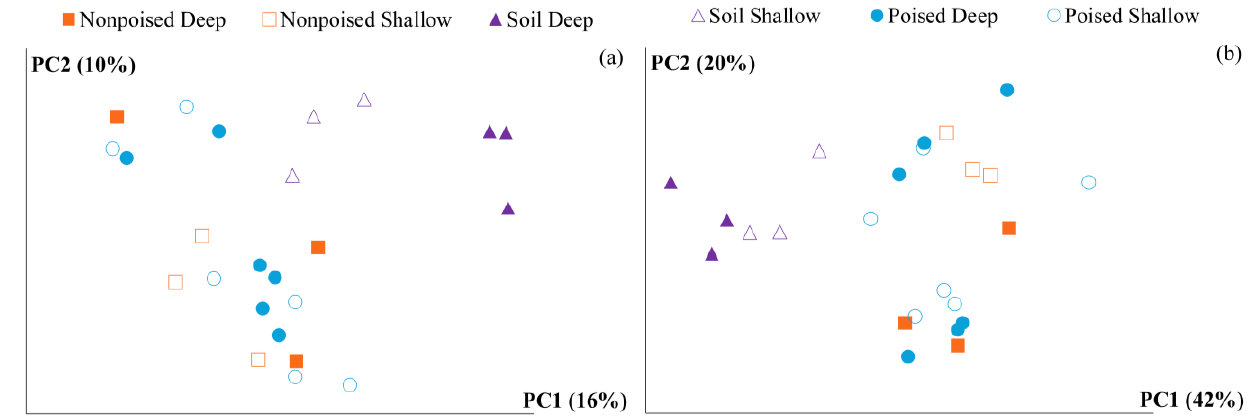
Figure 4. Beta diversity analysis of microbial communities showed using both ( a ) unweighted and ( b ) weighted UniFrac principal coordinates. Both unweighted and weighted analysis reveals clustering of soil samples at deep (filled triangles) and shallow (open triangles) depths, however difference in communities from nonpoised (squares) and poised (circles) electrodes are less distinct. Weighted UniFrac, which takes the sequence abundance into account, explains more of the variation in the first two principal coordinates (62% of variation explained) than the unweighted UniFrac analysis (26% of variation